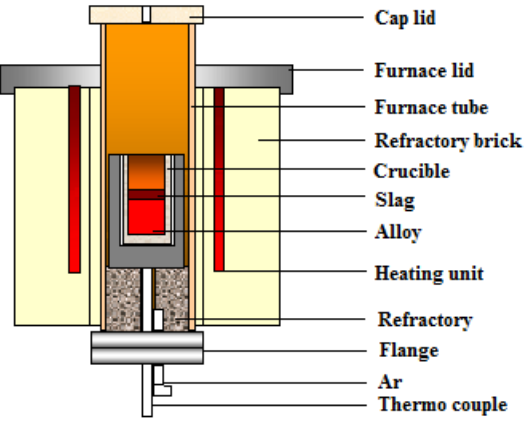
Figure 1. Schematic diagram of experimental equipment (MoSi 2 furnace). Table 1. Chemical composition of synthesized refining